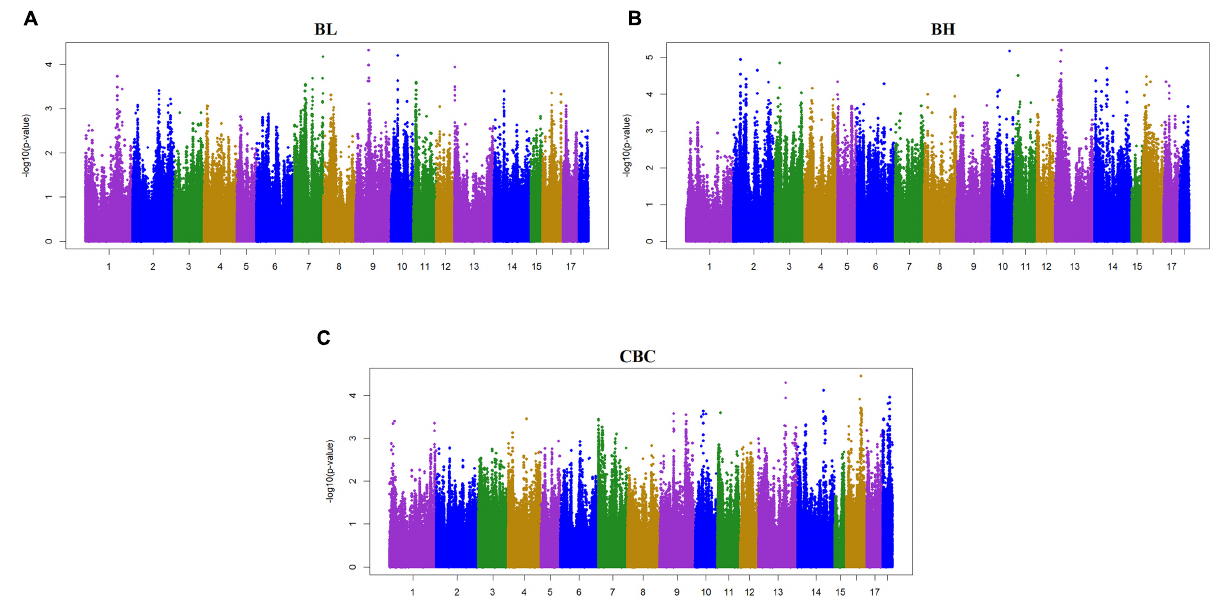
FIGURE 1 | Manhattan plot of the genome-wide association study on three body size traits by using single-trait model ssGWAS. BL, Body length; BH, Body height; CBC, Cannon bone circumference.In the Manhattan plots, negative log10 P -values of the quantified SNPs were plotted against their genomic positions. The x -axis represents the chromosomes and the y-axis represents the observed − log10( P -value). Different colors indicate various chromosomes. Each trait has a significant threshold of FDR adjusted, for (A) BL, it was 9.26 × 10 − 6 . Similarly, (B) BH was 1.08 × 10 − 5 , and (C) CBC was 1.02 × 10 − 5